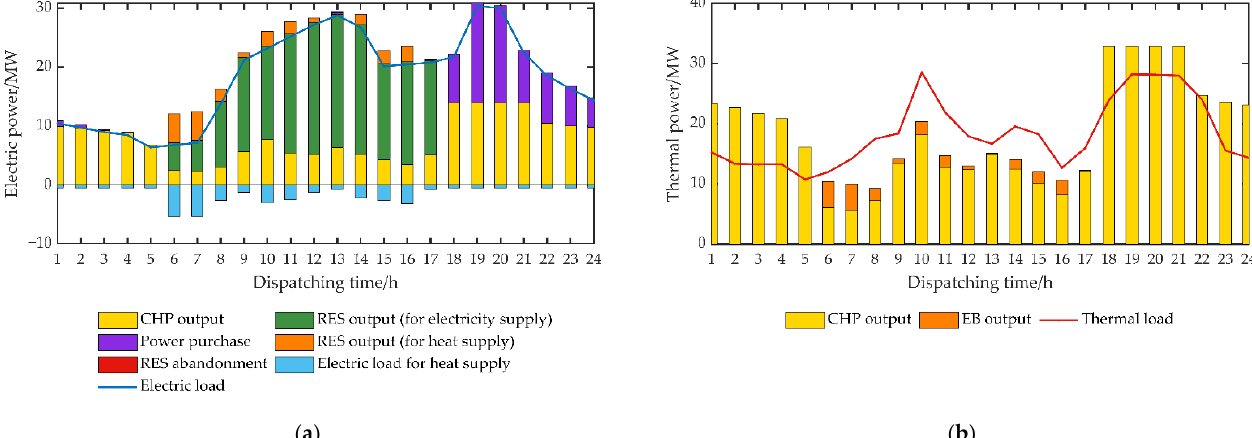
Figure 7. Independent dispatching in the residential area: ( a ) Electric power; ( b ) Thermal power.